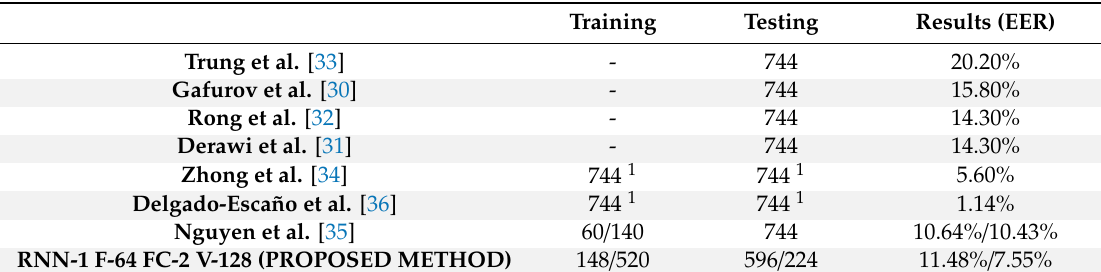
Table 5. EERs of benchmark